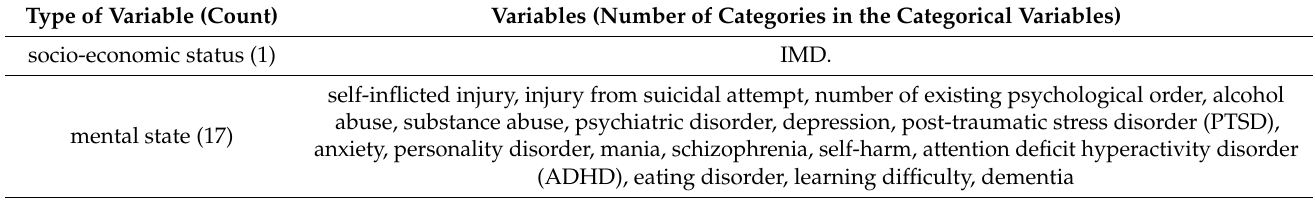
Table 1. Variables used in this study grouped by type, and an indication count for categorical variables. Type of Variable (Count) Variables (Number of Categories in the Categorical Variables)